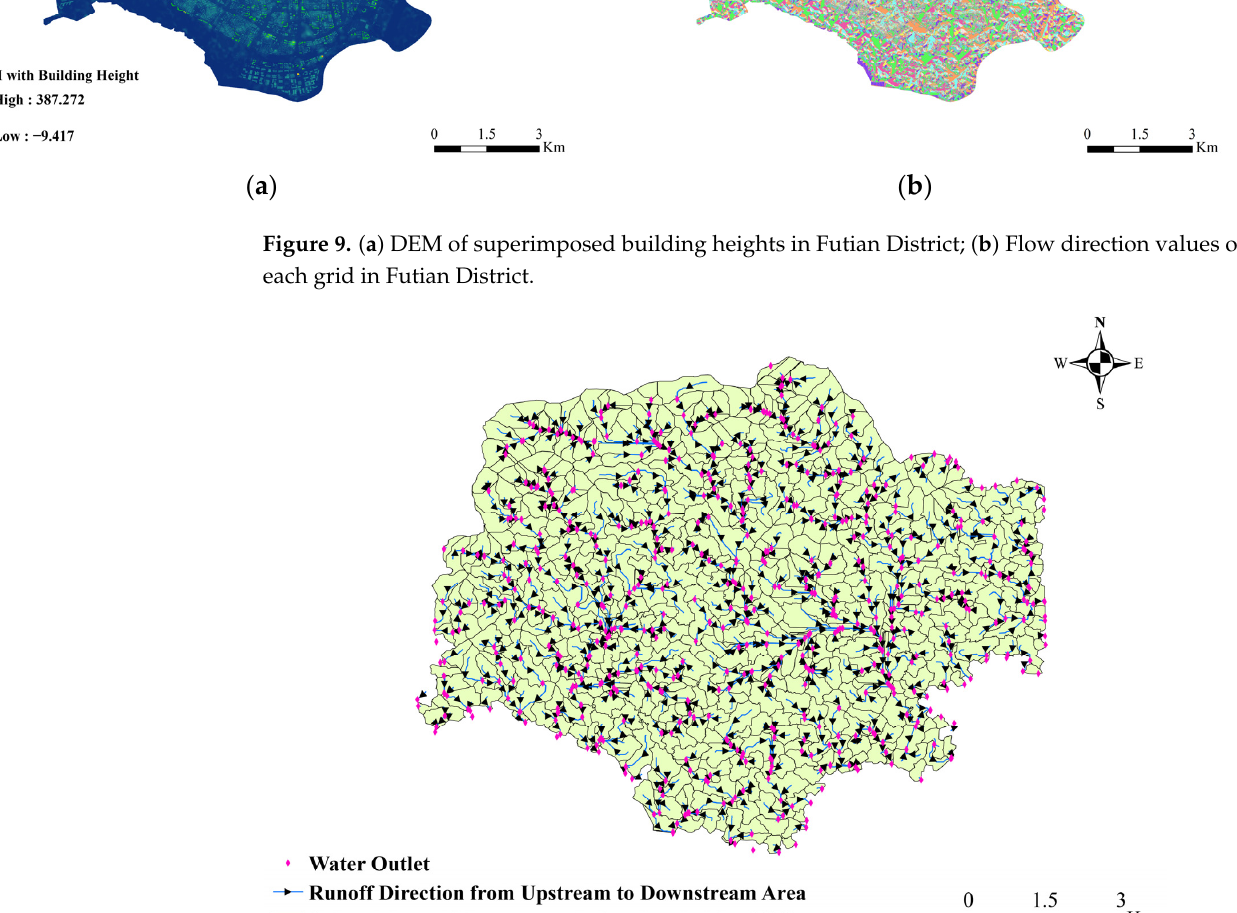
Figure 10. Runoff connectivity between the 596 sub-catchments.